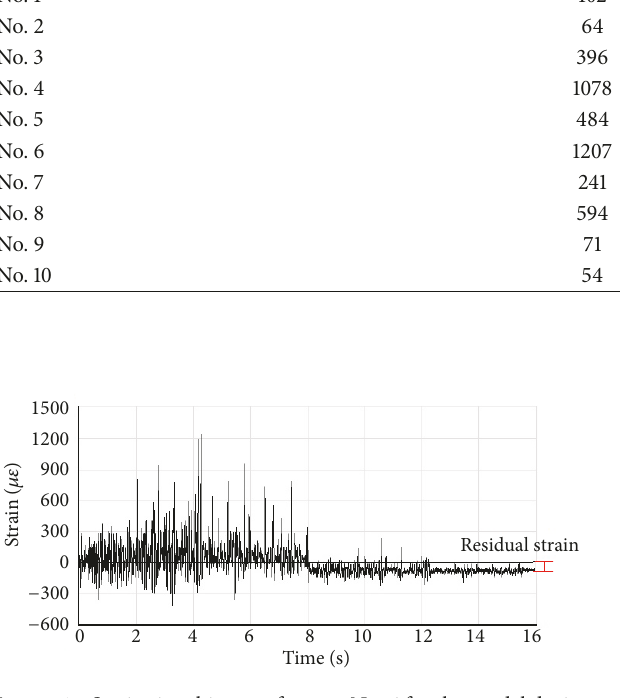
Figure 15: Strain time history of sensor No. 6 for the model during Load Case